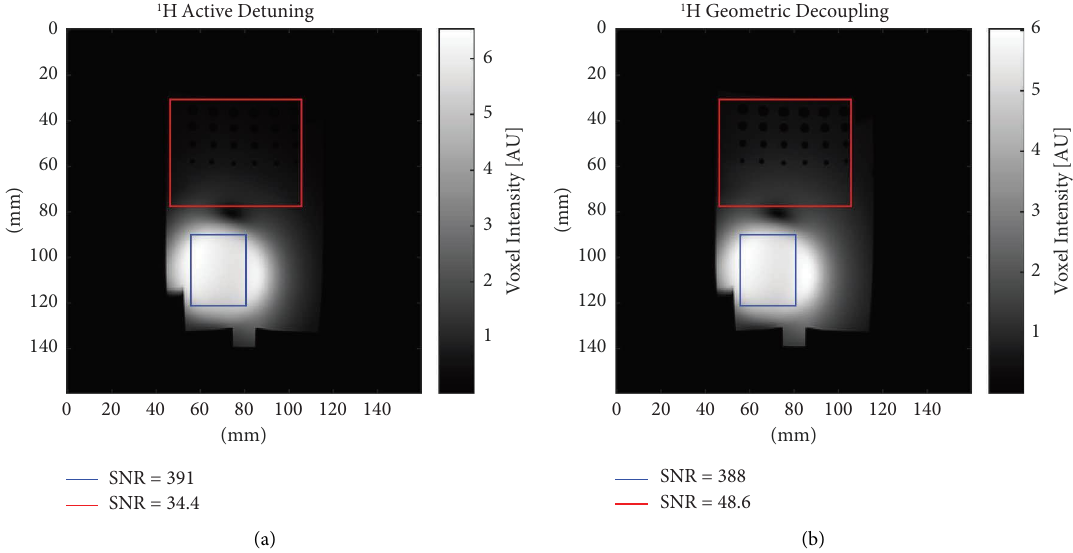
Figure 8: Images using the double-tuned birdcage with receive loop. (a) 1 H image receiving with a single loop using active detuning. (b) 1 H image receiving with a single loop using purely geometric